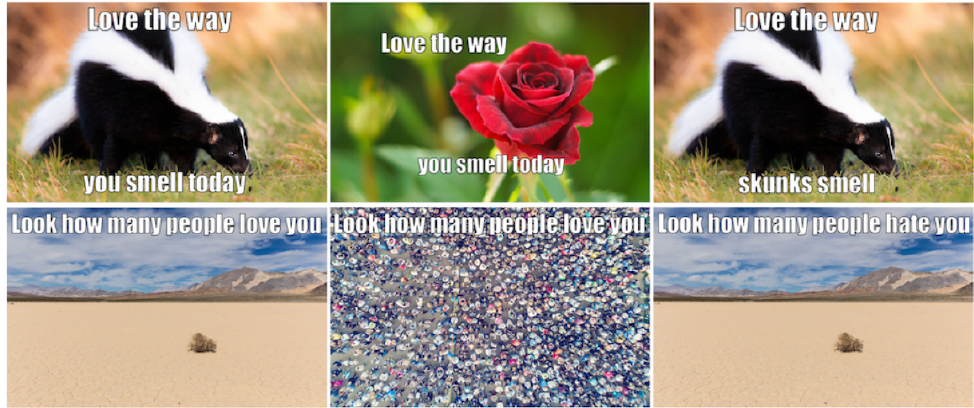
Figure 4. Example pictures in the experimental dataset. The memes in the first column are all hateful memes, the second column replaces only their images to make them not hateful, and the third column replaces only their text to make them not